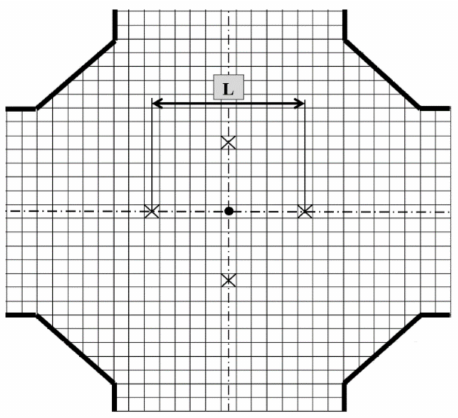
Figure 9. Characteristic dimension “L” for strain calculation in the gauge region of the cruciform